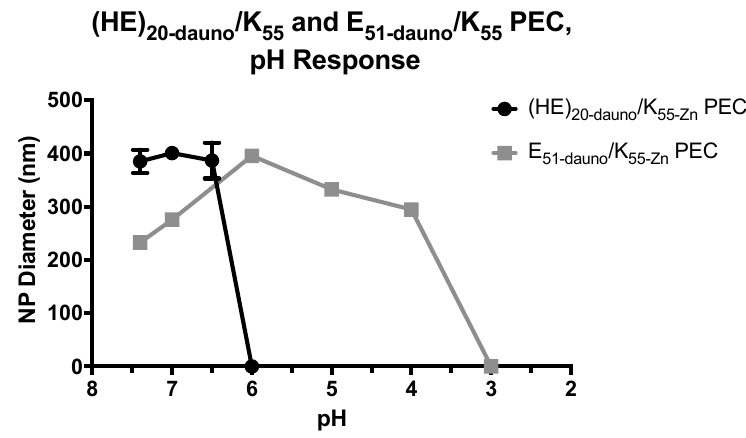
Figure 8 . pH dependence of (HE) 20-dauno /K 55-Zn PEC and E 51-dauno /K 55-Zn PEC formulated with (HE) 20 demonstrate a high degree of pH sensitivity, with complete complex degradation between pH 6.5–6.0. Complex size stayed constant until pH 6.0. PEC formulated from E 51 and K 55 showed high variability in complex size over the pH range tested and did not degrade until between pH 4.0–3.0. These data show that the pH sensitivity exhibited by the (HE) 20-dauno /K 55-Zn PEC is specifically mediated by the histidine present in (HE) 20 . Data shown are averages of 3–4 wells ± standard deviation.